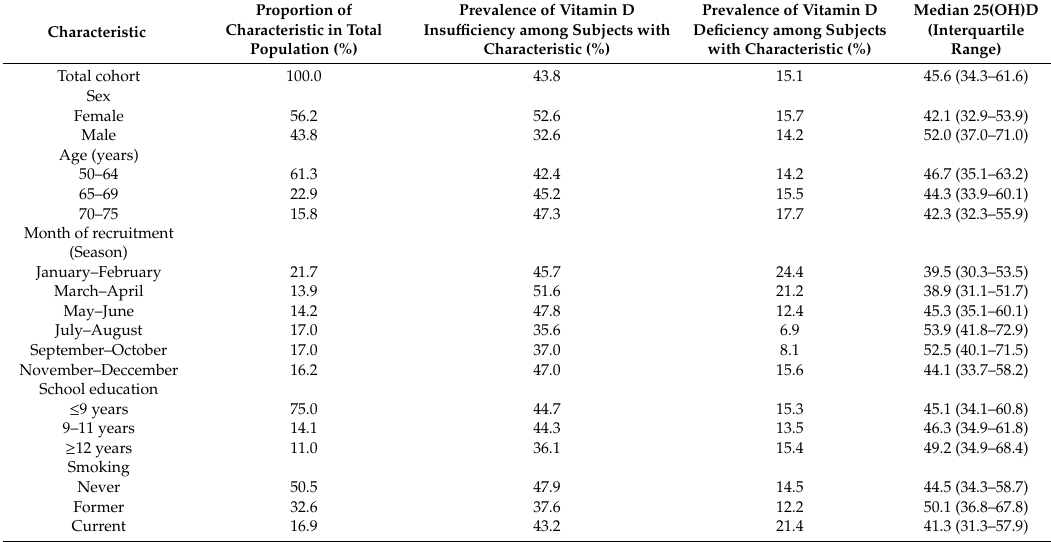
Table 1. Distribution of characteristics of the study population, prevalence of vitamin D deficiency and insu ffi ciency and distribution of 25(OH)D values by those